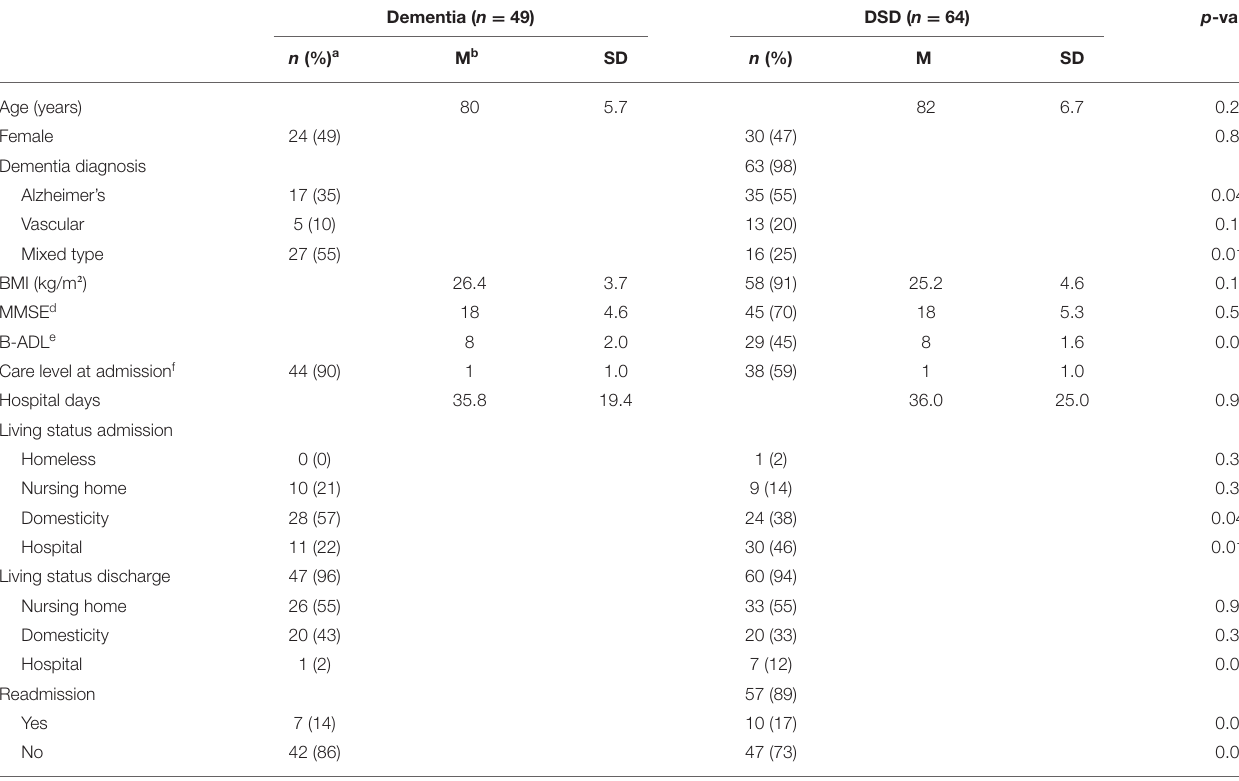
TABLE 1 | Characteristics according to delirium and dementia diagnosis.